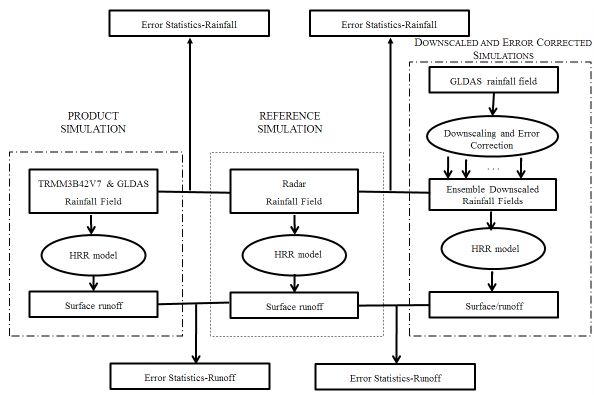
Figure 6. Flow diagram for the error analysis